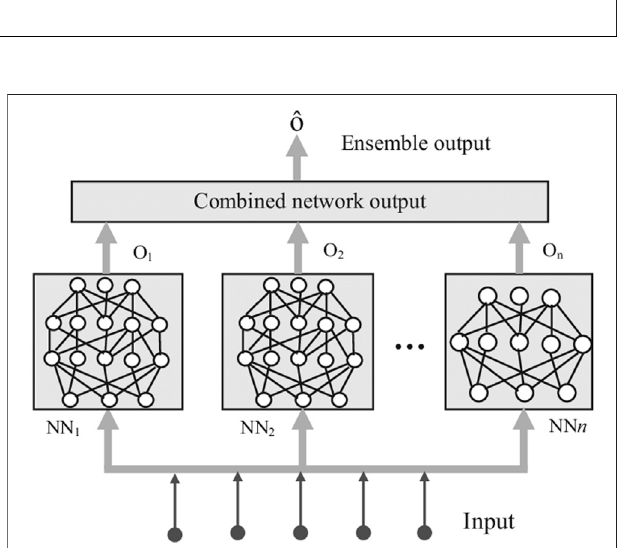
FIGURE 1 | Structure of LSTM neuron (Colah ’ s blog, 2020).